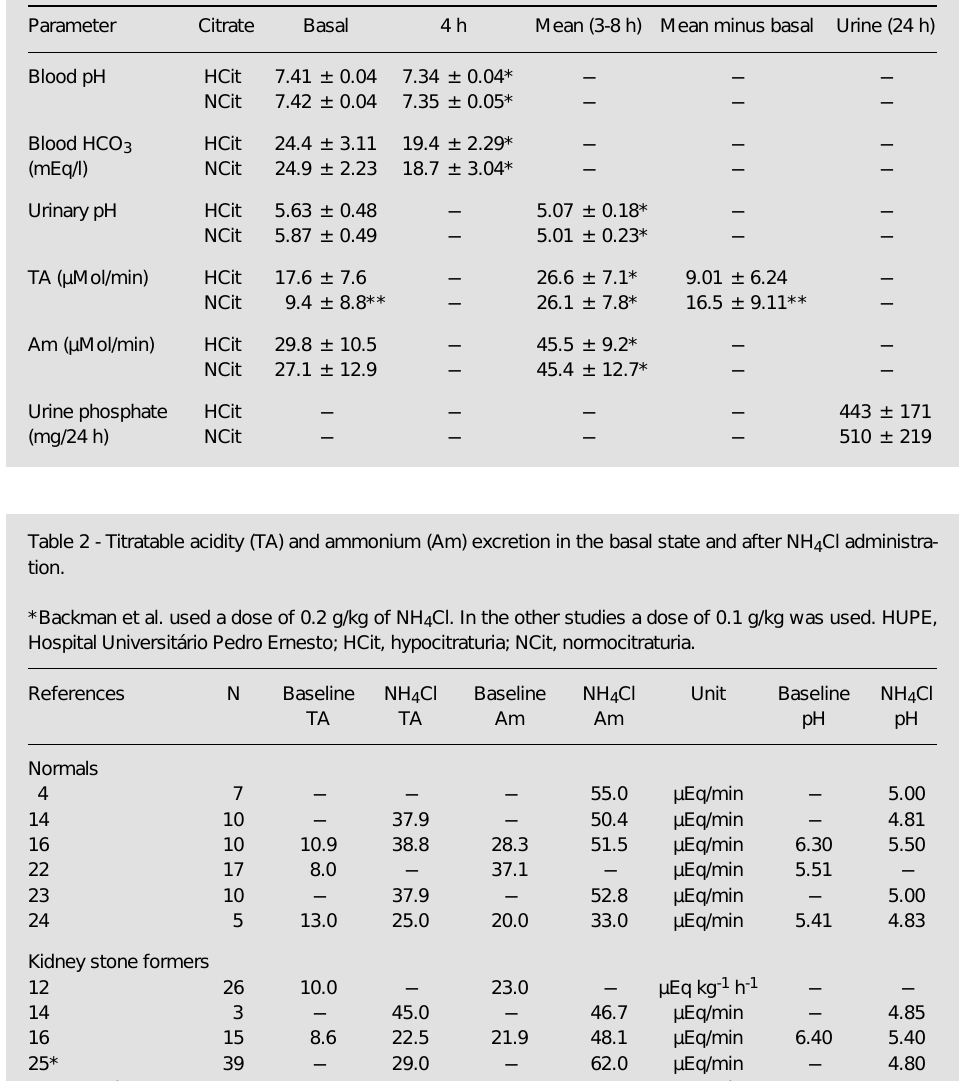
Table 1 - Effect of NH 4 Cl in blood and urinary chemistry.